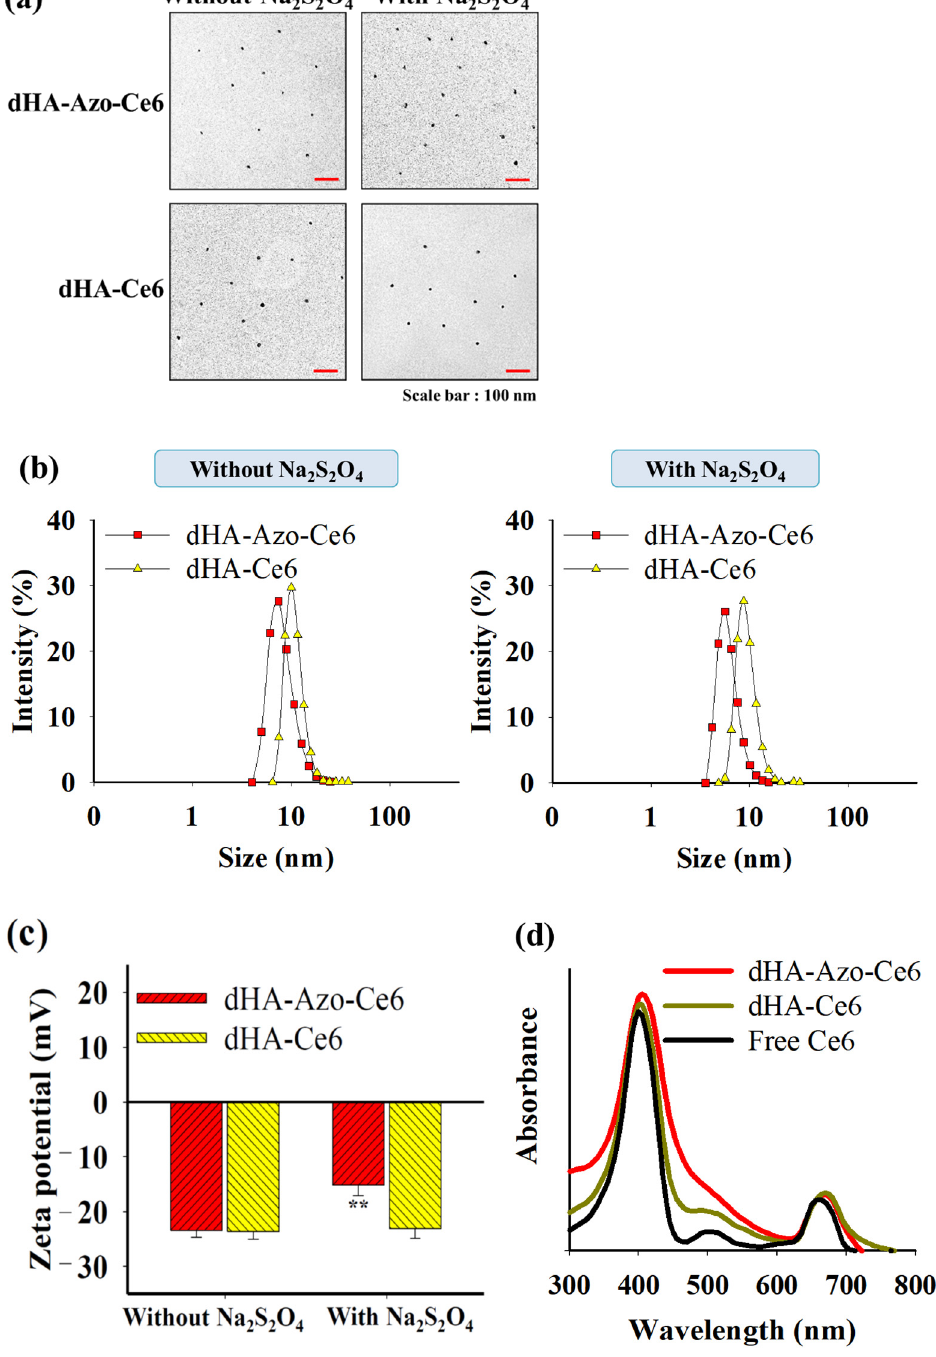
Figure 2. ( a ) TEM images of dHA-Azo-Ce6 and dHA-Ce6 with or without azo-reductase (Na 2 S 2 O 4 ) treatment. ( b ) Particle size distribution and ( c ) zeta potential values of dHA-Azo-Ce6 and dHA-Ce6 with or without azo-reductase (Na 2 S 2 O 4 ) treatment (n = 3, as multiple experiments, ** p < 0.01 compared to dHA-Ce6). ( d ) UV/Vis spectra of each sample (equivalent Ce6 10 µ g/mL) and free Ce6 (10 µ g/mL) in